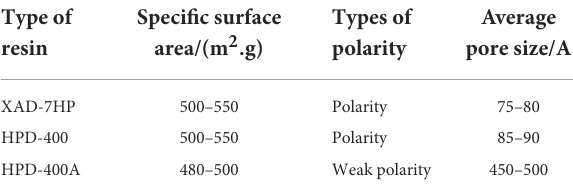
TABLE 1 Physical structure parameters of different macroporous